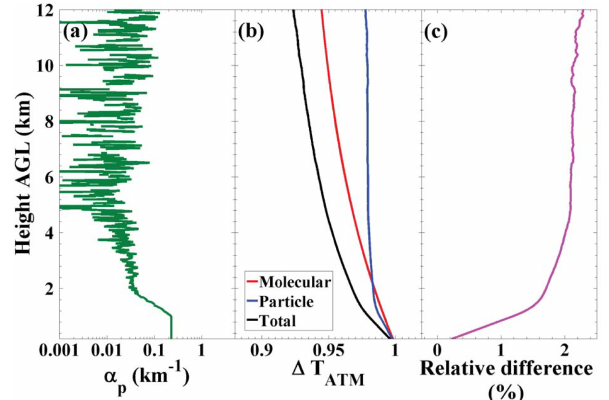
Figure 1. (a) Aerosol extinction coefficient ( α p ). (b) Differential at- mospheric transmission ( (cid:49)T ATM , see Eq. 2): total (black), particles (blue) and molecules (red). (c) Relative difference between differ- ential transmissions when considering and ignoring the contribution of particles to atmospheric transmission.